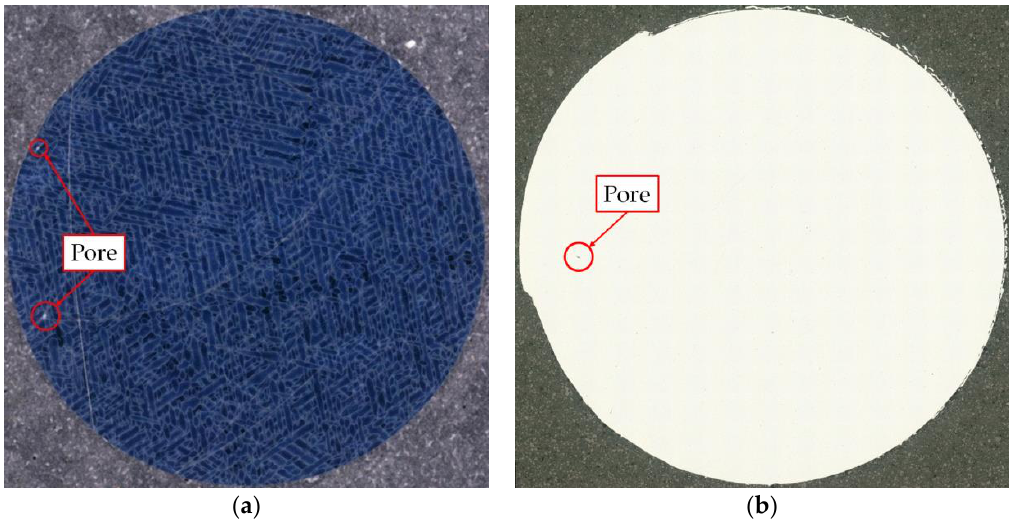
Figure 5. Micrograph of an ( a ) as-built and ( b ) HIP sample.